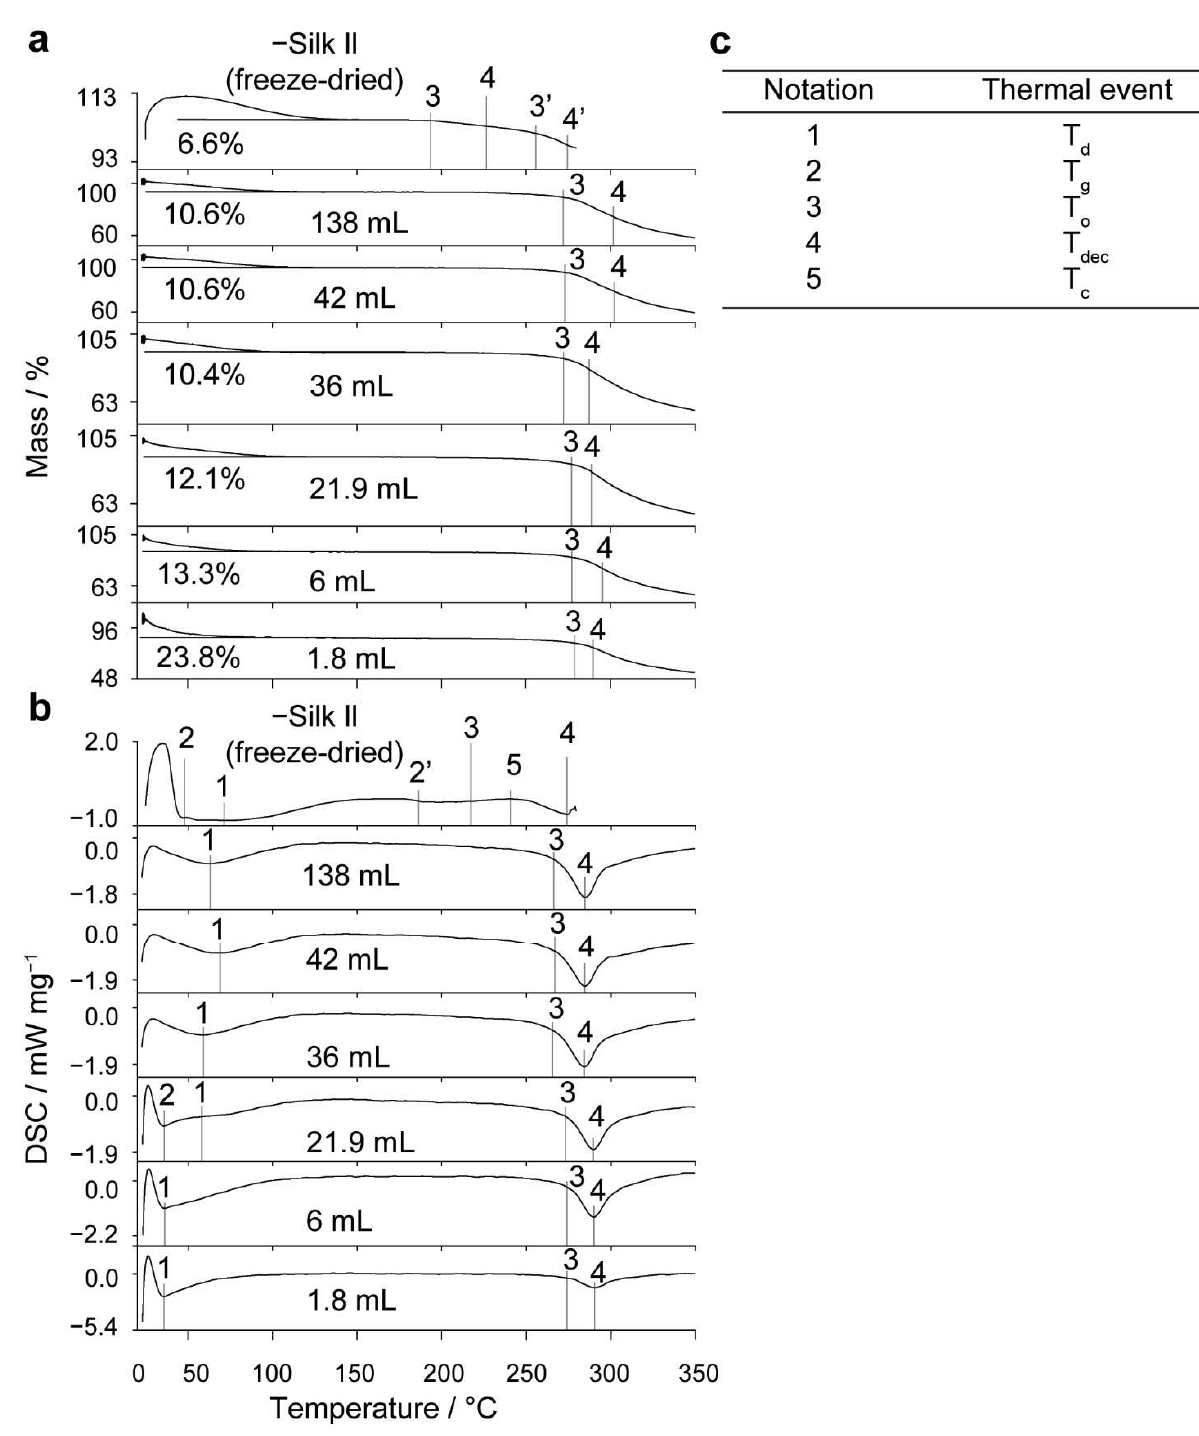
Figure 6. Representative first-cycle raw ( a ) TGA and ( b ) DSC thermograms of silk nanoparticles manufactured in open semi-batch format at different volumetric scales. ( c ) Thermal event assignment key. Water content (% ( w / w )), dehydration temperature (T d ), glass transition temperatures (T g ), extrapolated onset temperature of crystallization and decomposition (T o ), crystallization temperature (T c ), and decomposition temperatures (T dec ) are reported. The data shown for the negative silk II control (freeze-dried powder) were published elsewhere [30].